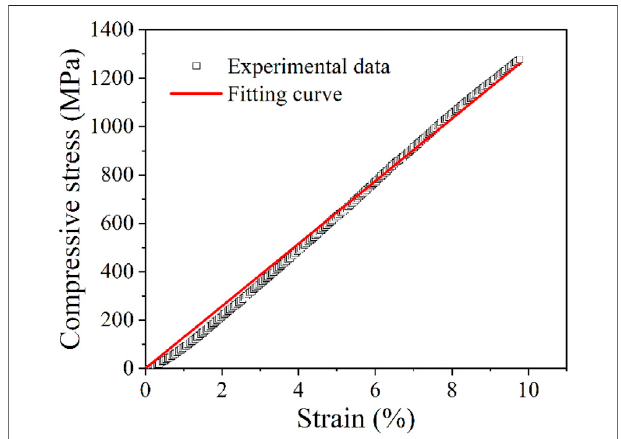
FIGURE 6 | Compression curve of SF/nHAp composites.